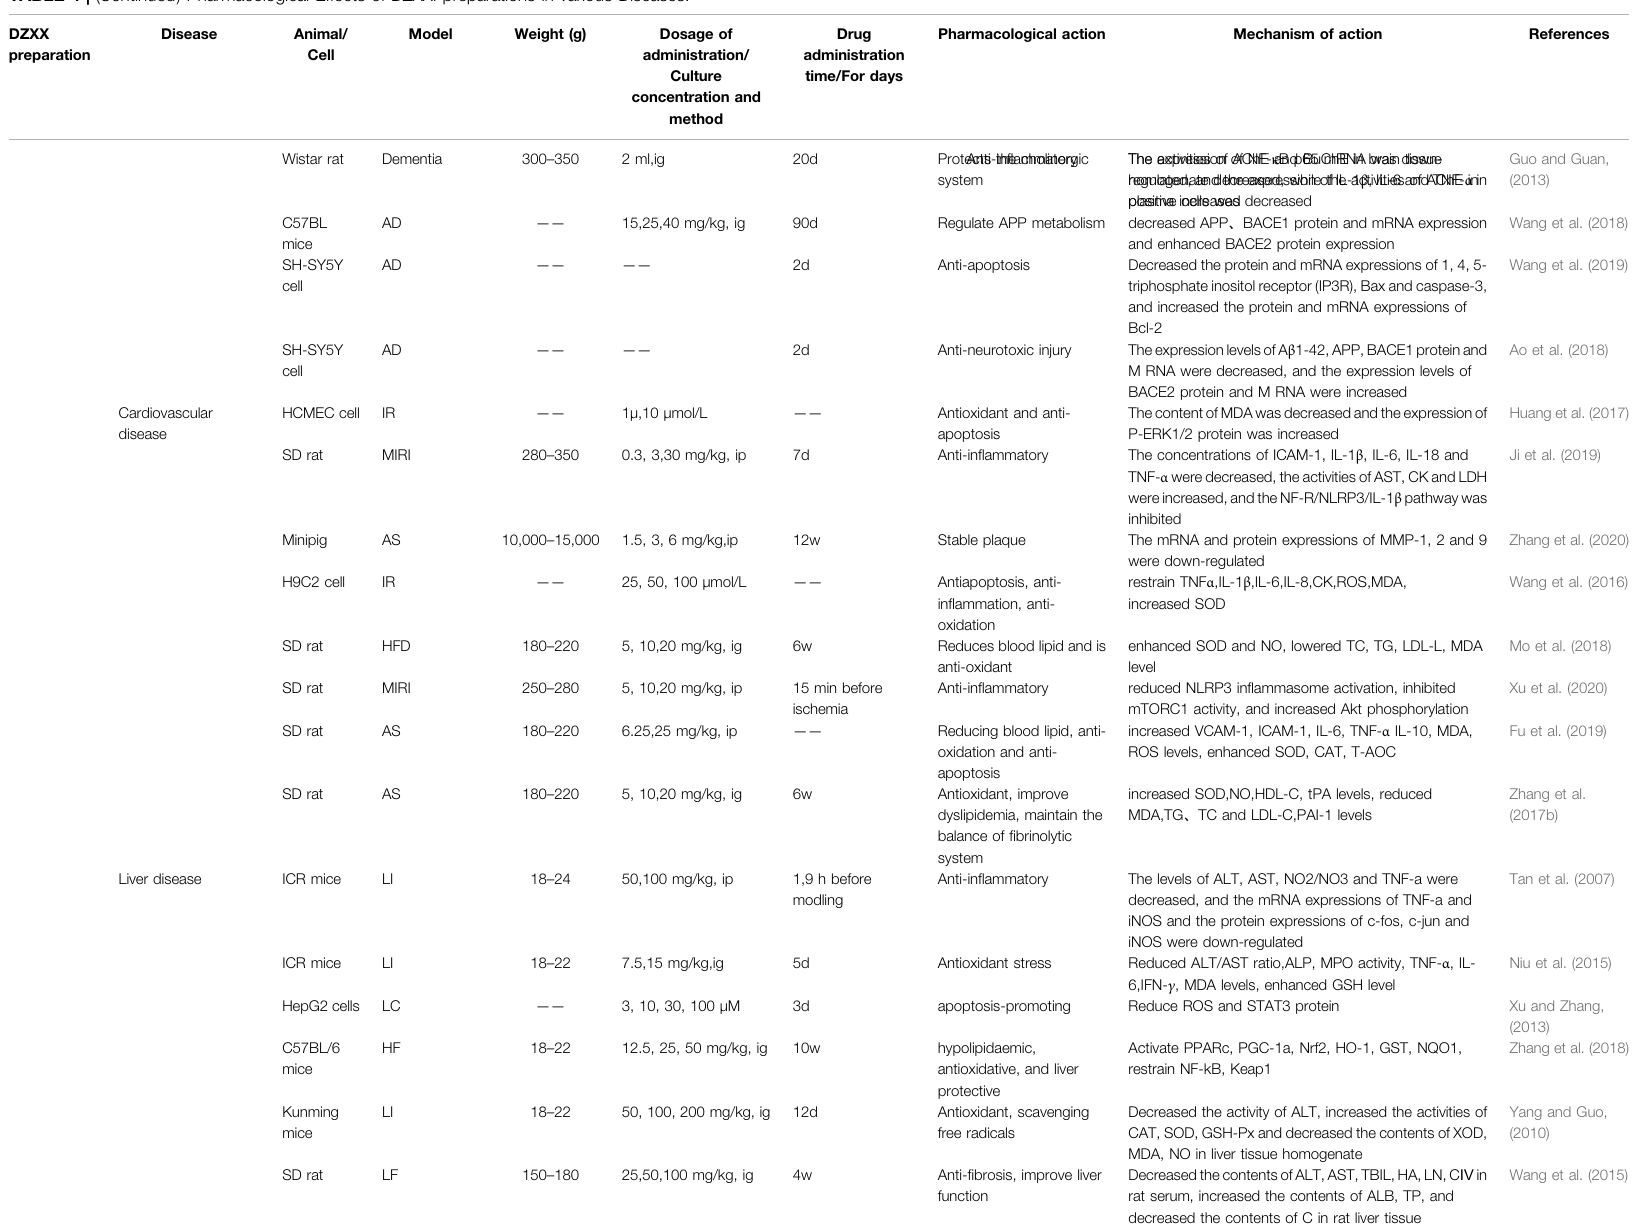
TABLE 4 | ( Continued ) Pharmacological Effects of DZXXI preparations in various